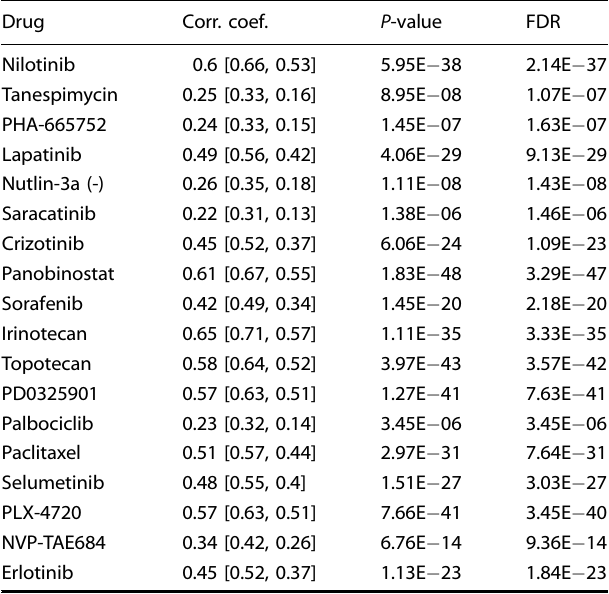
Fig. 1 TARGETS Work fl ow. Flowchart depicting TARGETS model training on DNA and RNA sequencing data from the Genomics of Drug Sensitivity in Cancer (GDSC) database to predict drug response. Model training was performed utilizing Elastic Net regression. The drug models were locked and subsequently validated on three independent cohorts: the Cancer Cell Line Encyclopedia (CCLE), The Cancer Genome Atlas (TCGA) pan-cancer database, and the West Coast Dream Team (WCDT) metastatic prostate cancer database. Table 1. TARGETS predictions correlate with CCLE drug